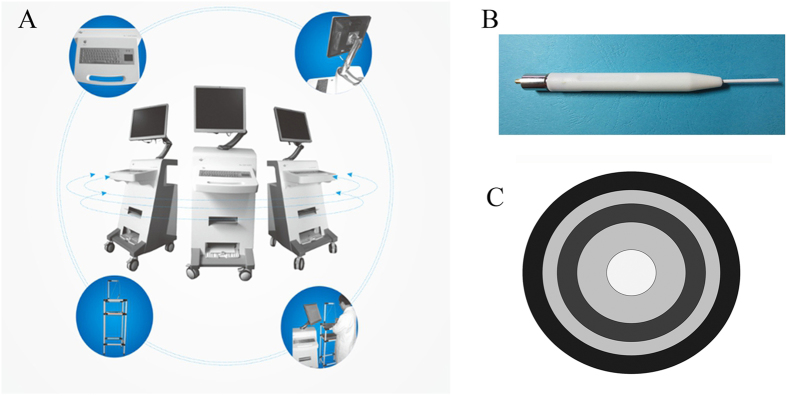
Structure and accessories of Na-1 Na+ detector.(A) The apparatus is composed of four fundamental parts: probe, host (sensor and processor), mornitor and operating table. (B) Overall structure of the probe. (C) Diagram of transversal surface of the probe.